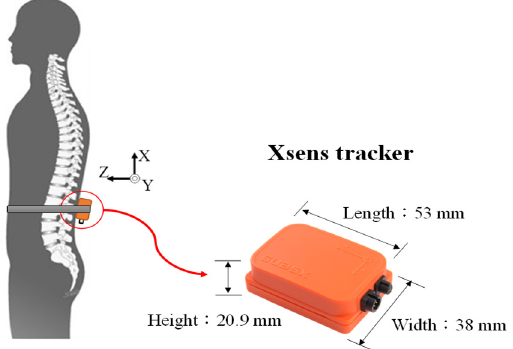
Figure 5. The tracker position of the participant (from Shieh et al. (2016)).